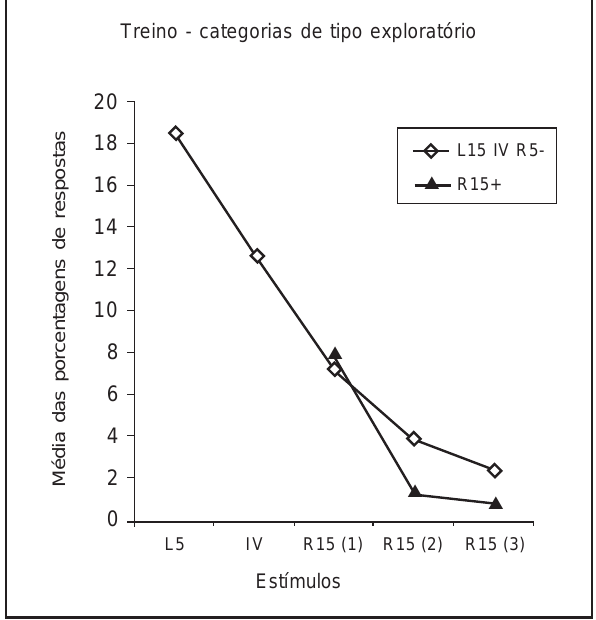
Figura 2b. Média das porcentagens de respostas das categorias de tipo exploratório agrupadas (locomoção, levantar-se, farejar e farejar próximo ao bebedouro) nas práticas L5 IV R15- e R15+, durante as 5 últimas sessões da fase de aquisição. L= luz; R= Ruído; IV= intervalo vazio; R15(1), R15(2) e R15(3) correspondem a blocos de 5 segundos de R15.